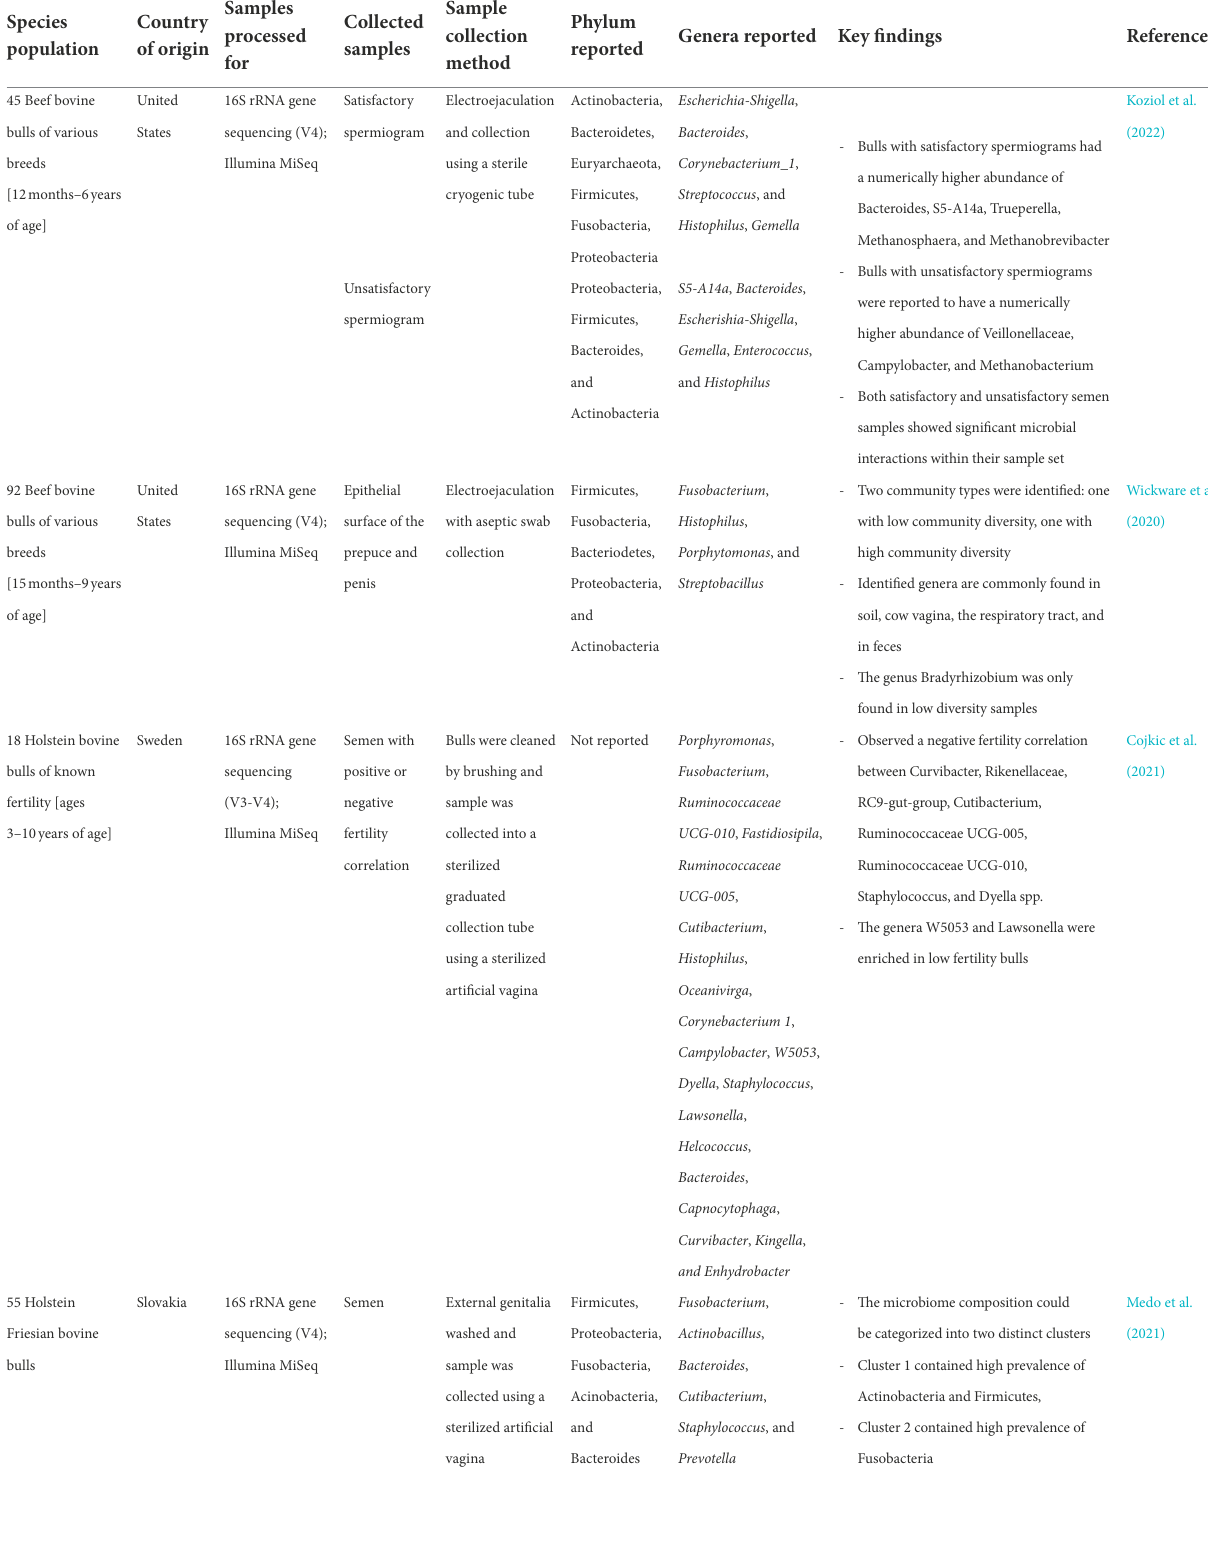
TABLE 1 Taxonomic identification of male reproductive tract-associated microbiota from several recent high-throughput sequencing-based